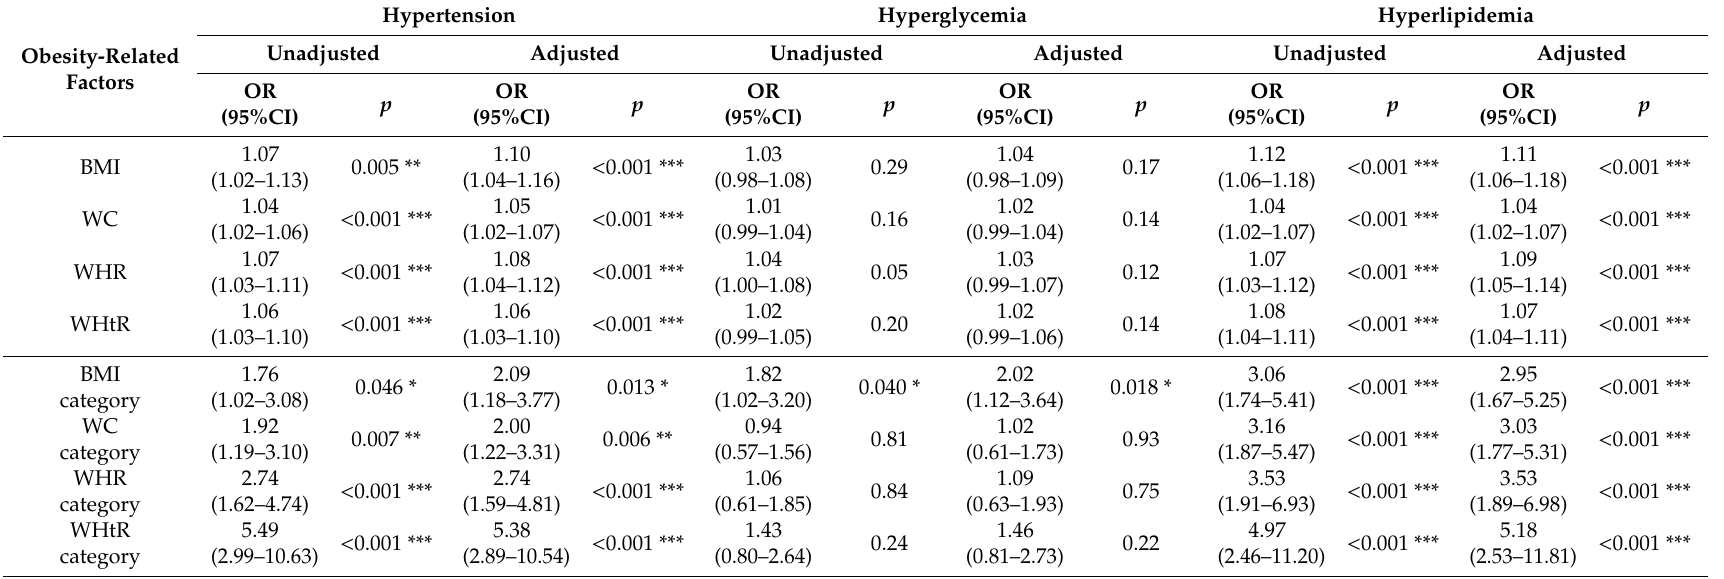
Table 3. Adjusted odds ratios (ORs) for cardiovascular disease (CVD) markers for obesity-related